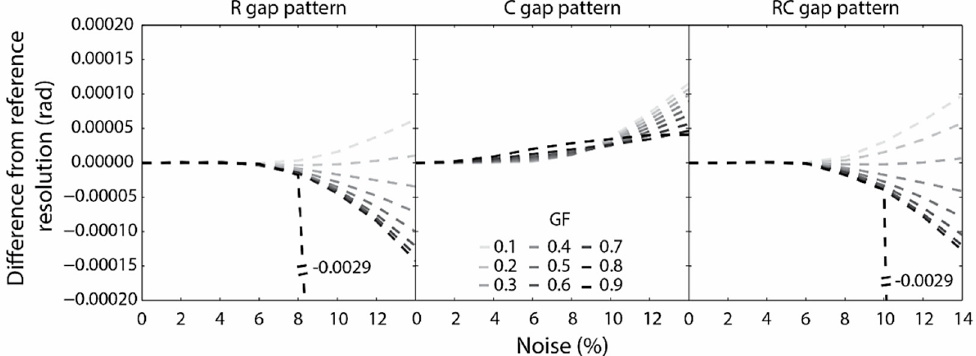
Figure 7. Difference between reference angular resolution and the computed one as the average of the θ and ϕ directions.